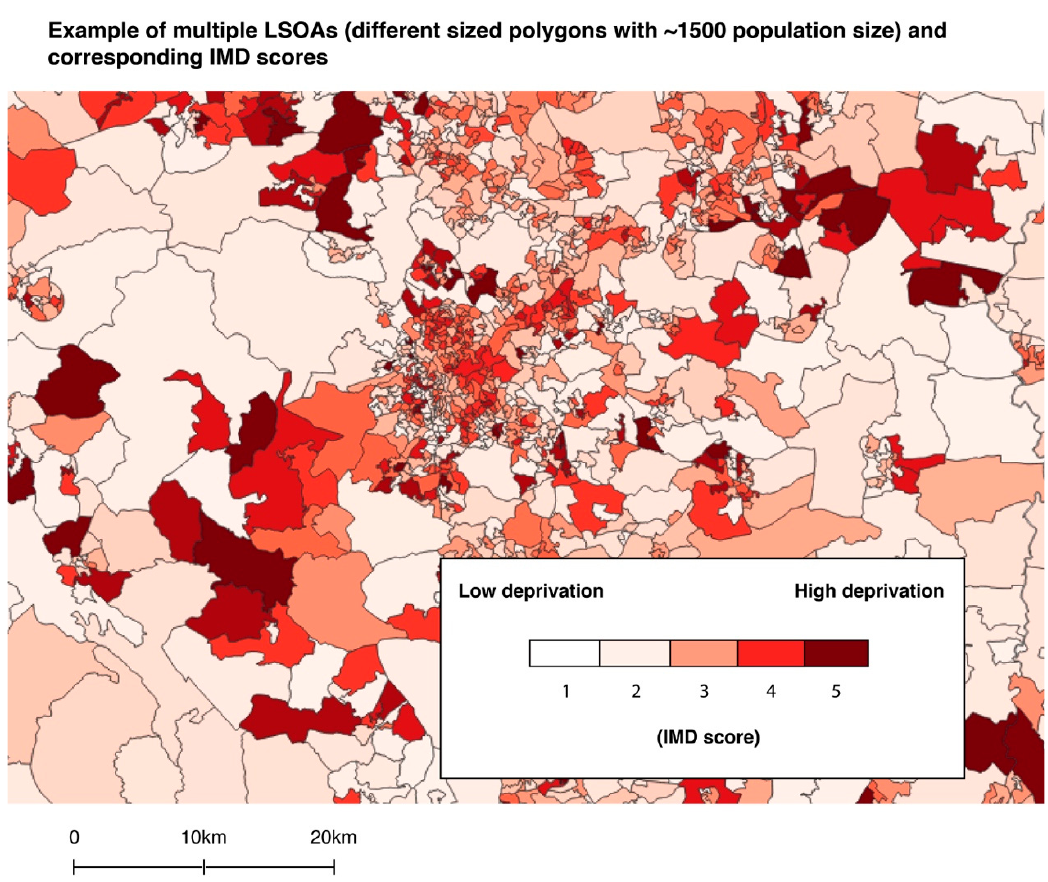
Figure 3. Example of Lower Super Output Areas (LSOAs) (boundaries) with Index of Multiple Deprivation (IMD) scores using ‘categorised’ symbology in QGIS.